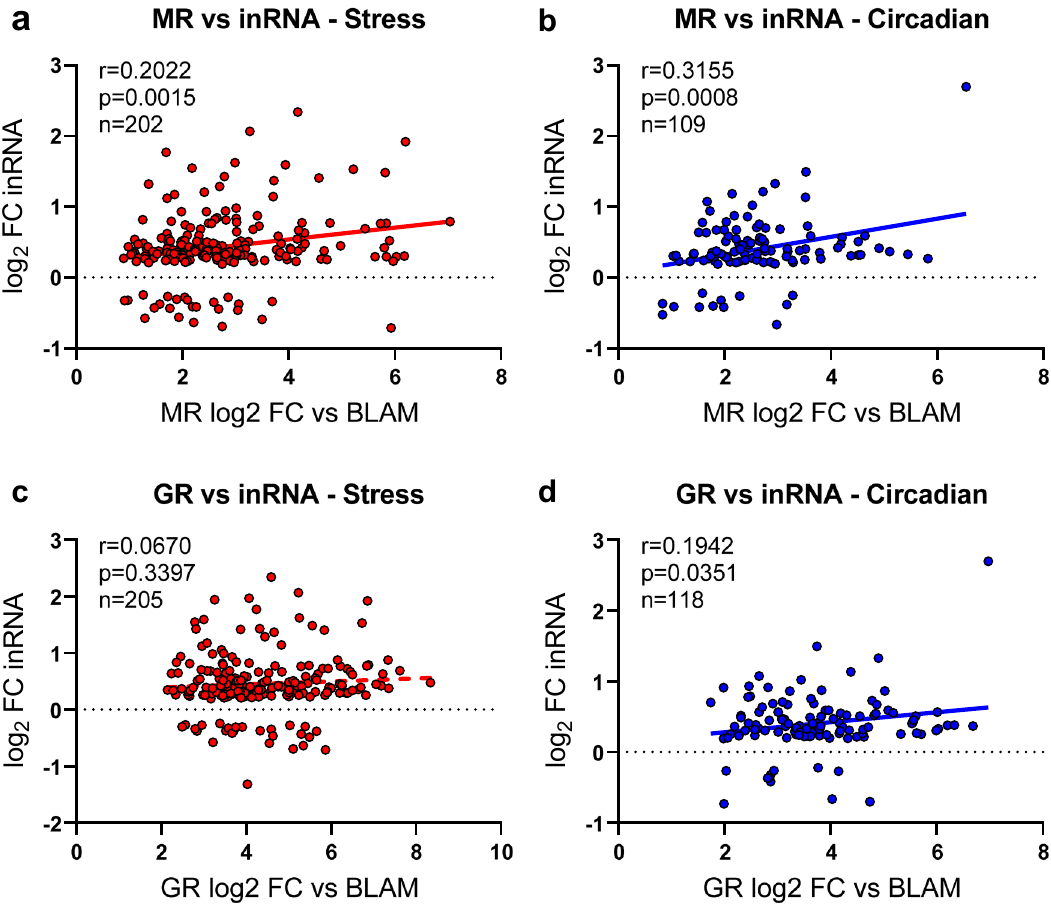
Fig. 5 Spearman rank correlation analysis between the fold-change in receptor binding and the associated fold-change in RNA expression under stress and circadian conditions. The results of the correlation analysis are depicted in the sub fi gures. A signi fi cant positive correlation was found between the fold-change in MR binding and the fold-change in inRNA levels after exposure to acute stress ( a ) and during the circadian rise ( b ). The change in GR binding post-stress did not signi fi cantly correlate with the change in inRNA levels ( c ). The increased GR binding and the changes in inRNA levels as a result of the circadian rise, however, showed a signi fi cant positive correlation ( d ). Source data are provided in the Source Data